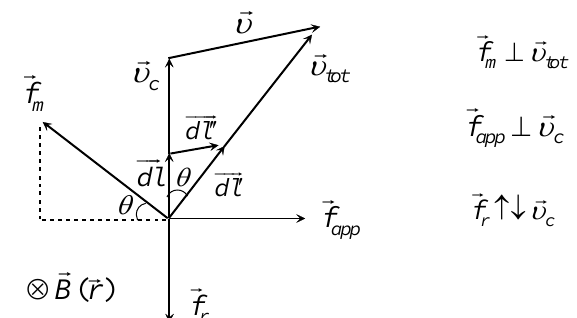
Figure 4: Balance of forces per unit